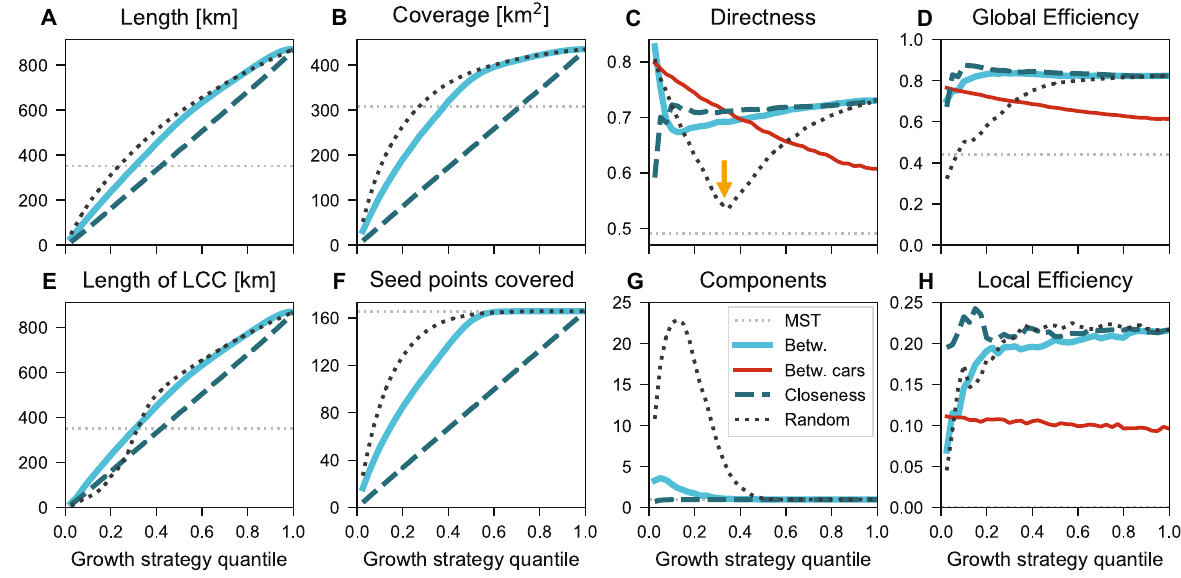
Figure 4. Different growth strategies optimize different network quality metrics. The three thick curves show the changes of network metrics with growth following three strategies (betweenness, closeness, or random) averaged over all 62 cities for grid seeds. By construction all curves arrive at the same endpoint, but they develop distinctly before that. For rail seeds and individual cities see Supplementary Figs. 5–10. Red curves show the car network’s simultaneous decrease of quality metrics if a five times decrease of speed limits is assumed for cars along all affected streets. Grey dotted lines show metrics for the minimum spanning tree (MST) that connects all seeds with minimal investment. Growth of ( A ) length, ( B ) coverage, ( C ) directness, ( D ) global efficiency, ( E ) length of LCC, ( F ) seed points covered, ( G ) connected components, ( H ) local efficiency. The yellow arrow highlights the substantial dip in directness until the critical threshold which is more pronounced for random growth than for betweenness